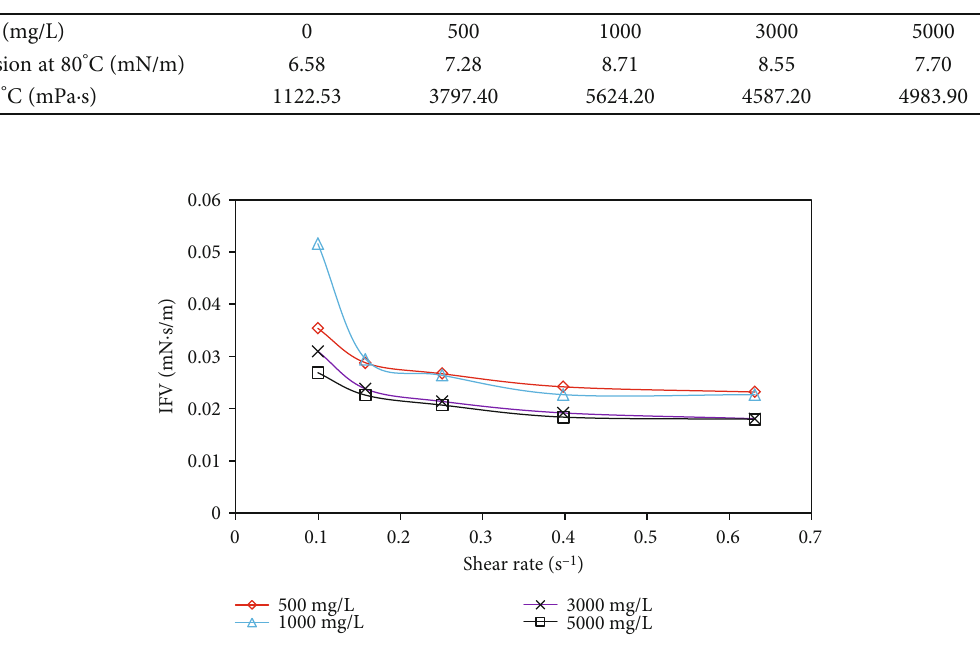
Figure 9: In fl uence of the water salinity on the interfacial shear viscosity between water and